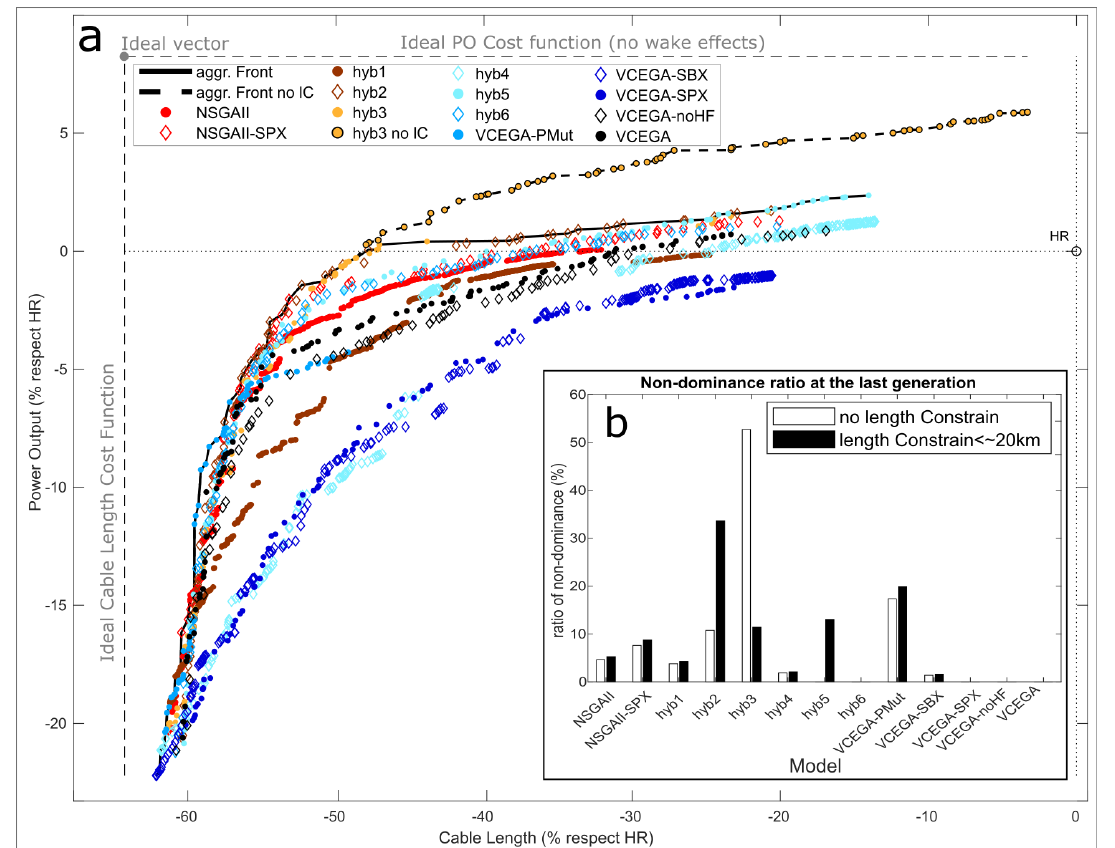
Figure 7. ( a ) Pareto fronts obtained from each algorithm at the final generation (see legend for color codes), and aggregated Pareto front applying (solid black line) and not applying (dashed black line) a maximum wind farm length constraint. ( b ) Ratio of non-dominance of each algorithm at the final generation, for both the constrained and unconstrained maximum wind farm length cases. Results highlight the largest role by the algorithm ‘hybrid3’ in the Aggregated Pareto front at the end of the run when no constrain is applied, and by ‘hybrid2’ when it is